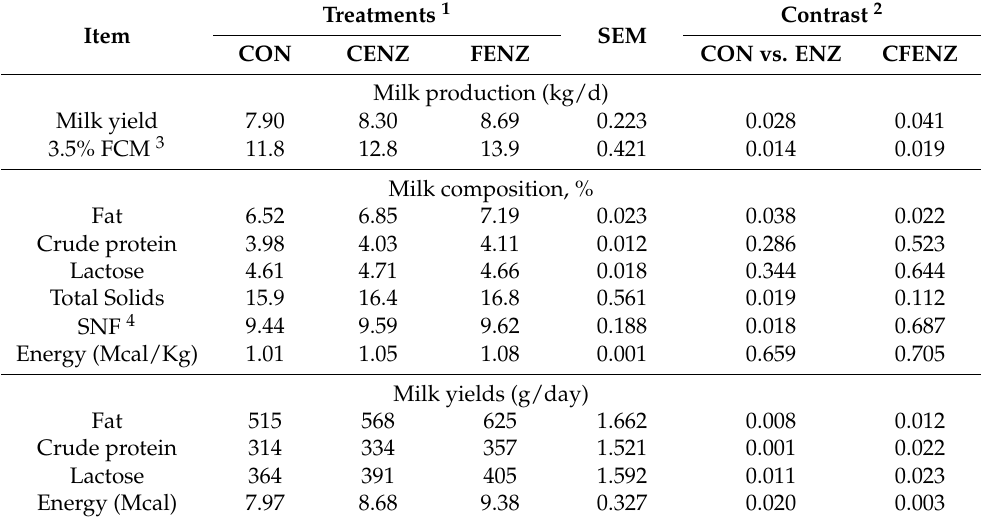
Table 3. Milk production performance of dairy buffaloes as affected by cellulase enzyme supplemen- tation to the diet.